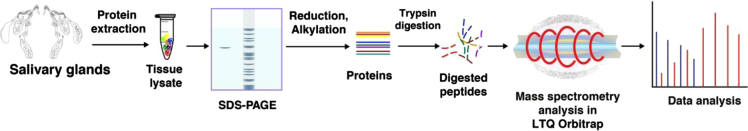
The workflow illustrating the steps involved in proteomic analysis of salivary gland of female Aedes aegypti.